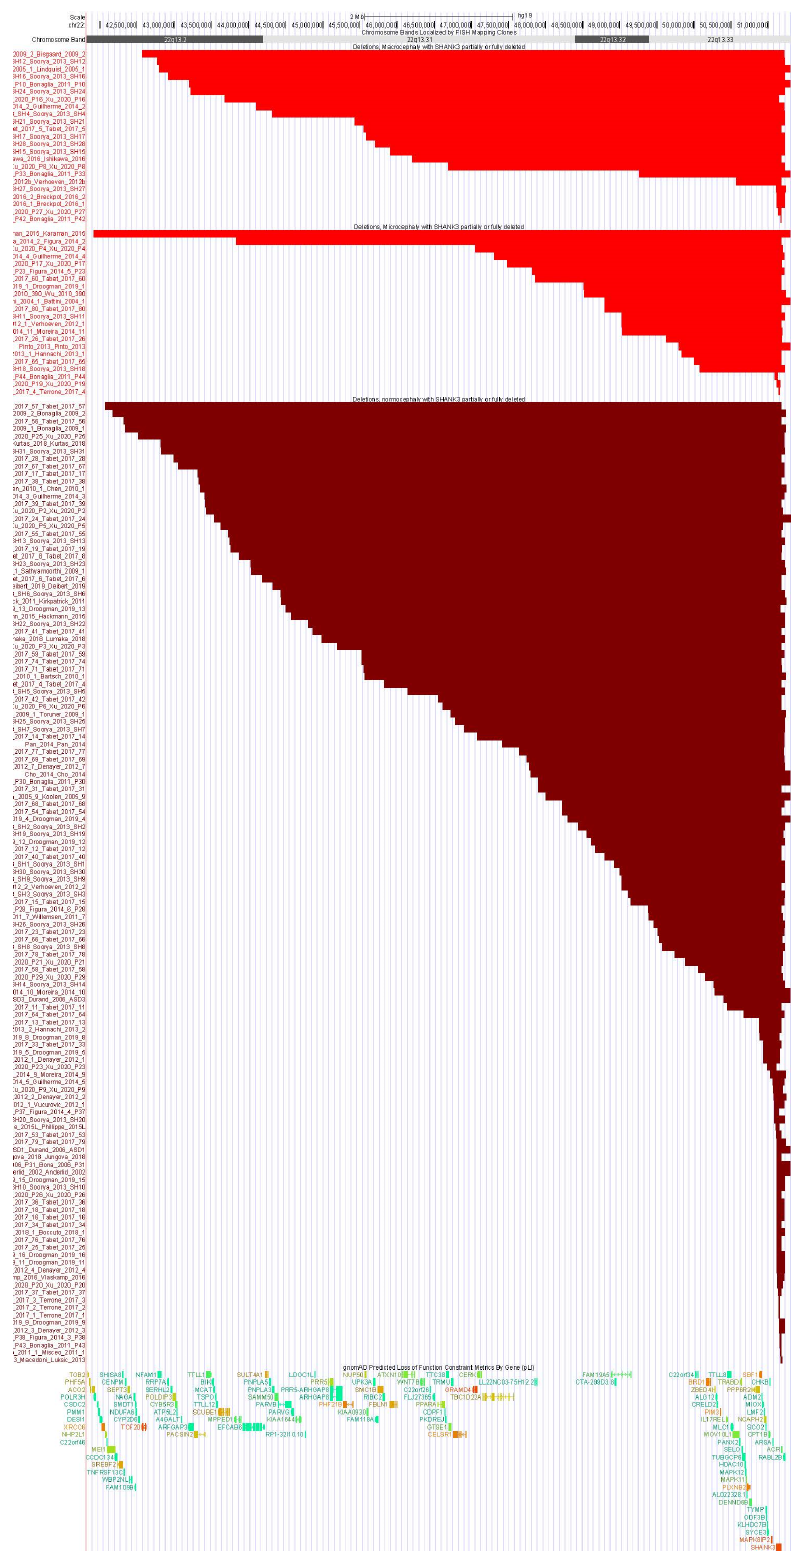
Figure 2. Distribution of deletions for individuals with macrocephaly (top), microcephaly (middle), and normocephaly (bottom panel) with SHANK3 partially or completely deleted. Note the preponderance of deletions > 1 Mb among individuals with microcephaly compared to those with normocephaly. Note the preponderance of deletions > 4 Mb among those with